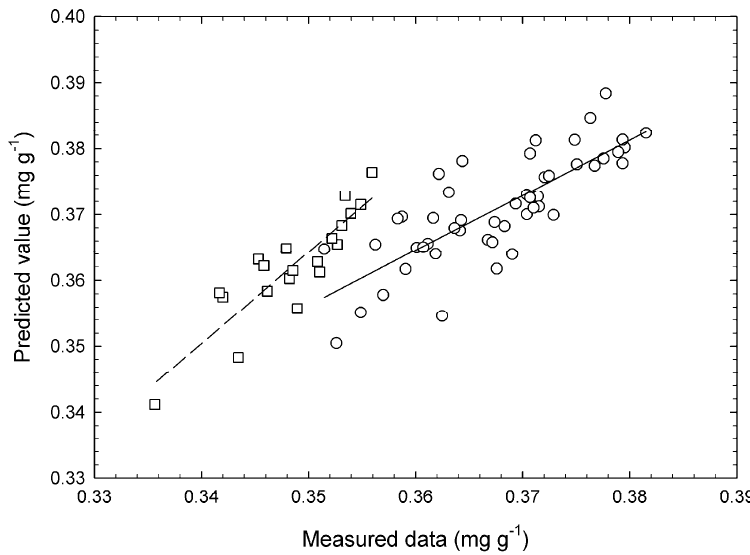
Figure 7. Relationship between measured and predicted chlorophyll concentrations after 3 and 7 d of storage. The circles and squares denote the plots for days 3 and 7, respectively. The solid lines denote the linear regression lines for day 3 (Bias 3.31 × 10 − 3 mg·g − 1 , standard error of prediction 5.03 × 10 − 3 mg·g − 1 ·d − 1 , correlative coefficient of validation 0.795; significant at the 99.9% level calculated using the F-test). The dashed lines denote the linear regression lines for day 7 (Bias 1.37 × 10 − 2 mg·g − 1 , standard error of prediction 4.33 × 10 − 3 mg·g − 1 ·d − 1 , correlative coefficient of validation 0.884; significant at the 99.9% level calculated using the F-test).